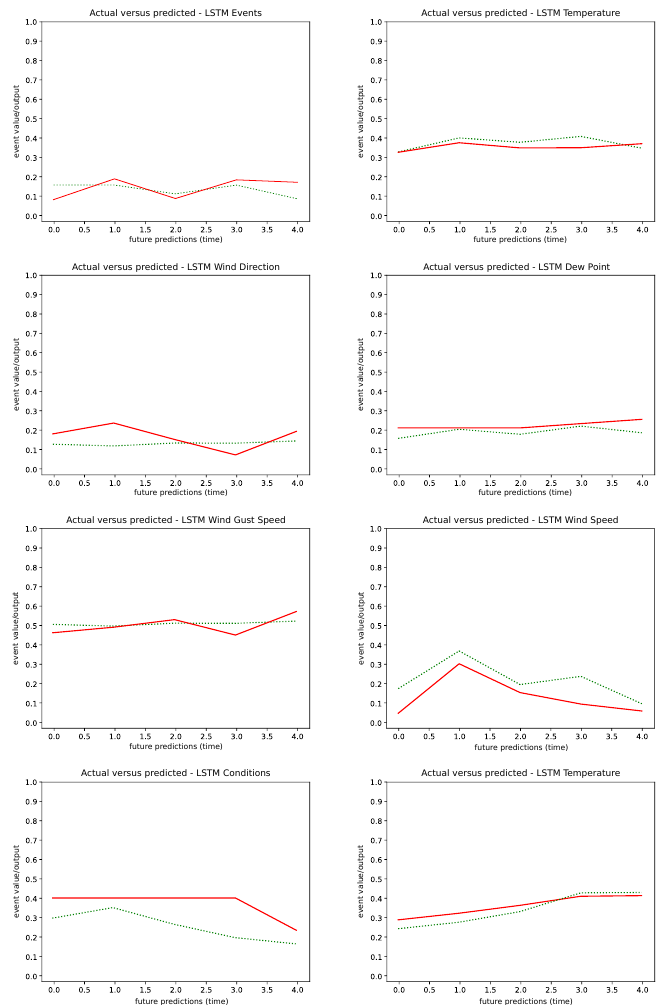
Figure 9. The sample outputs of the LSTM models for the events, wind direction, wind gust speed, conditions, temperature, dew point, wind speed and temperature weather features (from the top left to the bottom right in a column-row order). The green plot line is the measured (actual) value of the reported weather feature and the red plot line is the LSTM output predicting the weather conditions for the current and 40 min into the